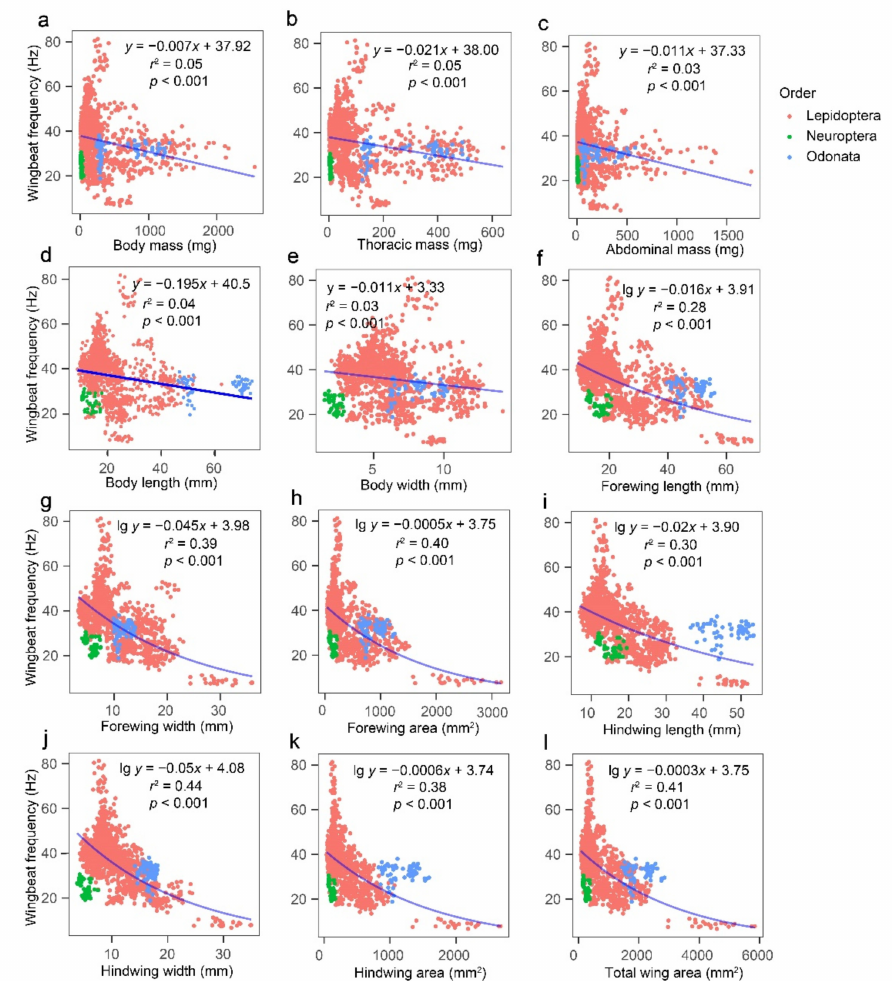
Figure 4. Relationships between wingbeat frequency and morphological variables ( a ) body mass, ( b ) thoracic mass, ( c ) abdominal mass, ( d ) body length, ( e ) body width, ( f ) forewing length, ( g ) forewing width, ( h ) forewing area, ( i ) hindwing length, ( j ) hindwing width, ( k ) hindwing area, and ( l ) total wing area, for all tested insects. N = 1458